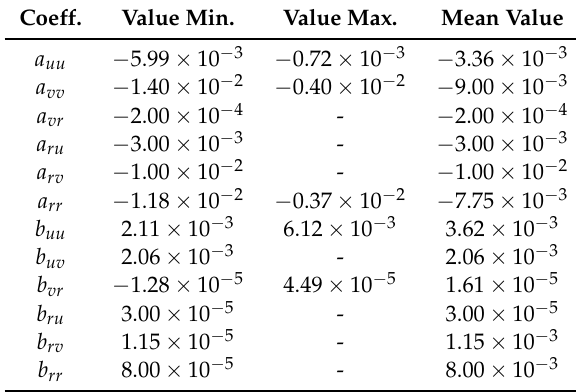
Table 2. Ship model coefficients values. Coeff. Value Min. Value